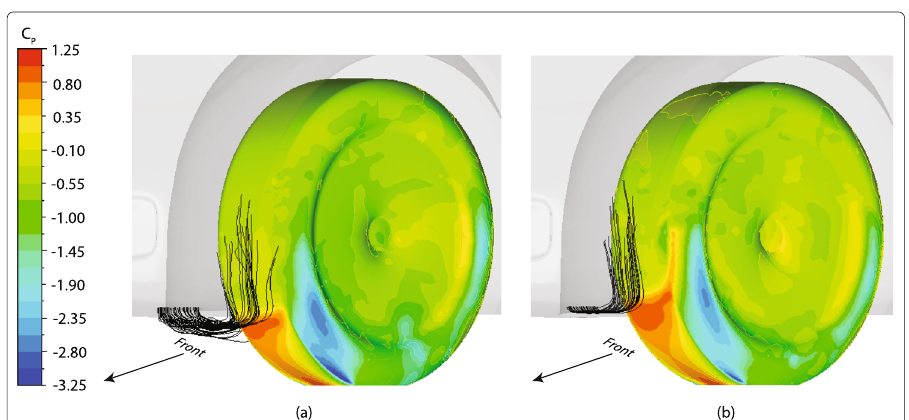
Fig. 20 Pressure coefficient contour diagram for the notchback DrivAer model for U ∞ = 45 m/s with U = 2/3 ( a ) 90 ◦ air-jet wheel deflector ( b ) 45 ◦ air-jet wheel deflector